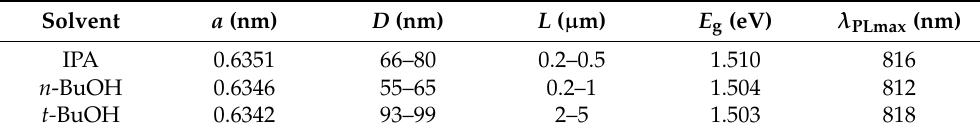
Table 1. Morphological and photophysical data ( a is lattice parameter, D crystallite size, L grain size, E g bandgap, λ PLmax maximum of